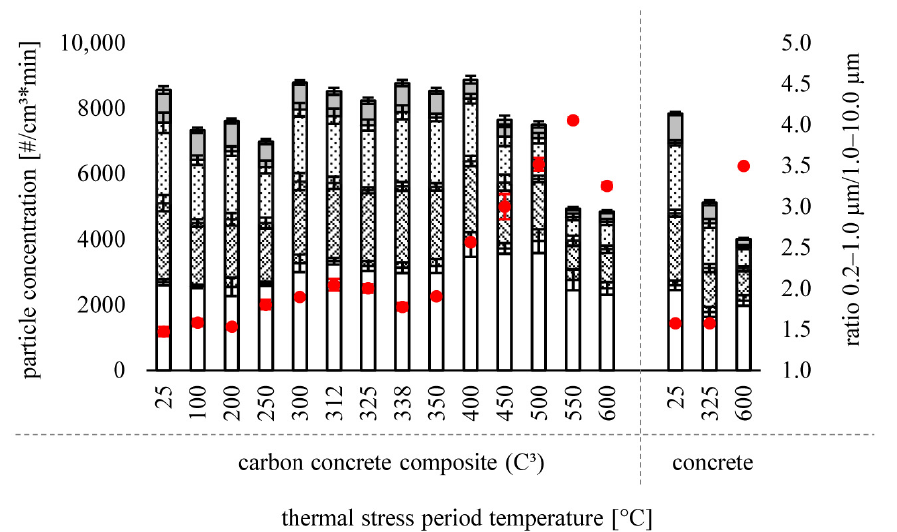
Figure 1. Particle concentration per cm 3 and minute divided into four groups by their scattered light-equivalent diameter formed during abrasive processing of thermally stressed C 3 materials and concrete (25–600 ◦ C, air atmosphere, 3 h). Error bars indicate the standard deviation of the distinct sizing group.